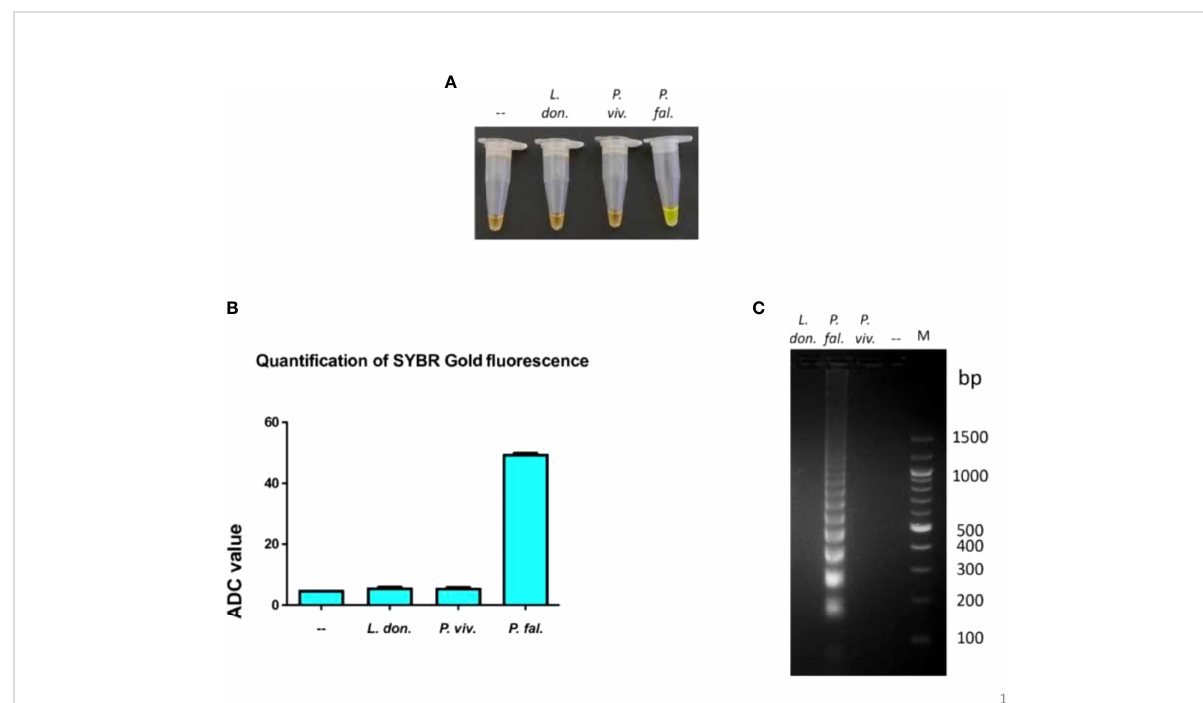
FIGURE 2 Exclusivity of the LAMP reaction performed in the device.The exclusivity of the LAMP reaction performed in the device was determined. One ng of genomic DNA from each of L. donovani Bob, P. vivax and P. falciparum strains was used in a LAMP reaction along with P. falciparum LAMP primers for 100 minutes, as described in Materials and Methods. (A) The con fi rmation of LAMP ampli fi cation was done by SYBR Gold detection. Diluted SYBR Gold nucleic acid stain was added to the LAMP products, and the color change was detected by visual examination. – : non- template control. (B) The quanti fi cation of SYBR Gold fl uorescence was done by measuring the fl uorescence intensity of the samples by a detection device, designated as ADC values. The mean + SEM of 10 ADC values are plotted for each sample. (C) Electrophoresis of LAMP products on a 2.5% agarose gel. M: 100 bp DNA